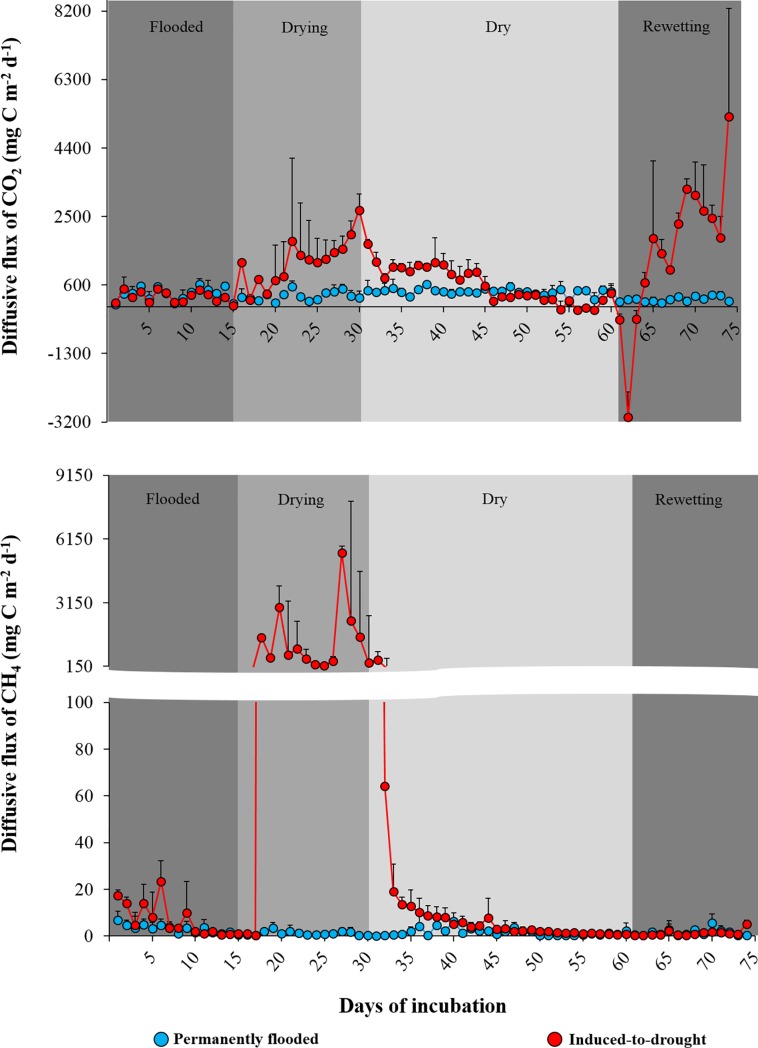
Diffusive flux of CO2
(upper) and CH4
(bottom) (average ± standard deviation; mg C m-2
d-1) from permanently flooded (blue) and induced-to-drought cores (red) across the different experimental periods. For a better view of results, only the upper standard deviation is shown.